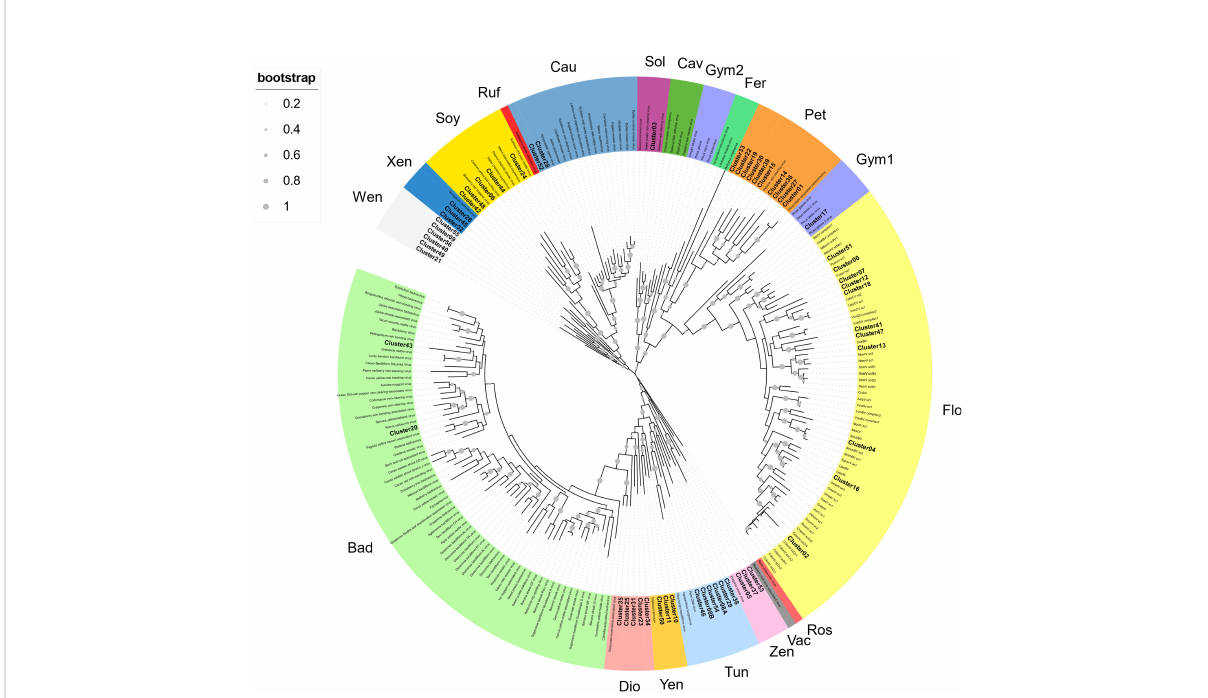
FIGURE 1 Phylogenetic relationships within the episomal and endogenous Caulimoviridae . Phylogram obtained from a maximum likelihood analysis with protein sequence data from RT conserved domains using 500 bootstrap replications. The size of the point indicated the bootstrap support of the tree branch. Known episomal and endogenous pararetrovirus are shown in grey and small letters. New endogenous Clusters60 are shown in bold letters. The color of the branch indicates the genus of Caulimoviridae ; Bad, Badnavirus ; Dio, Dioscovirus ; Yen, yendovirus ; Tun, tungrovirus ; Zen, zendovirus ; Vac, vaccinivirus ; Ros, rosadnavirus ; Flo, fl orendovirus ; Gym1 and Gym2, gymnendovirus 1 and 2; Pet, petuvirus ; Fer, fernendovirus ; Cav, cavemovirus ; Sol, solendovirus ; Cau, caulimovirus ; Ruf, ru fl odivirus ; Soy, soymovirus ; Xen, xendovirus ; and Wen, wendovirus